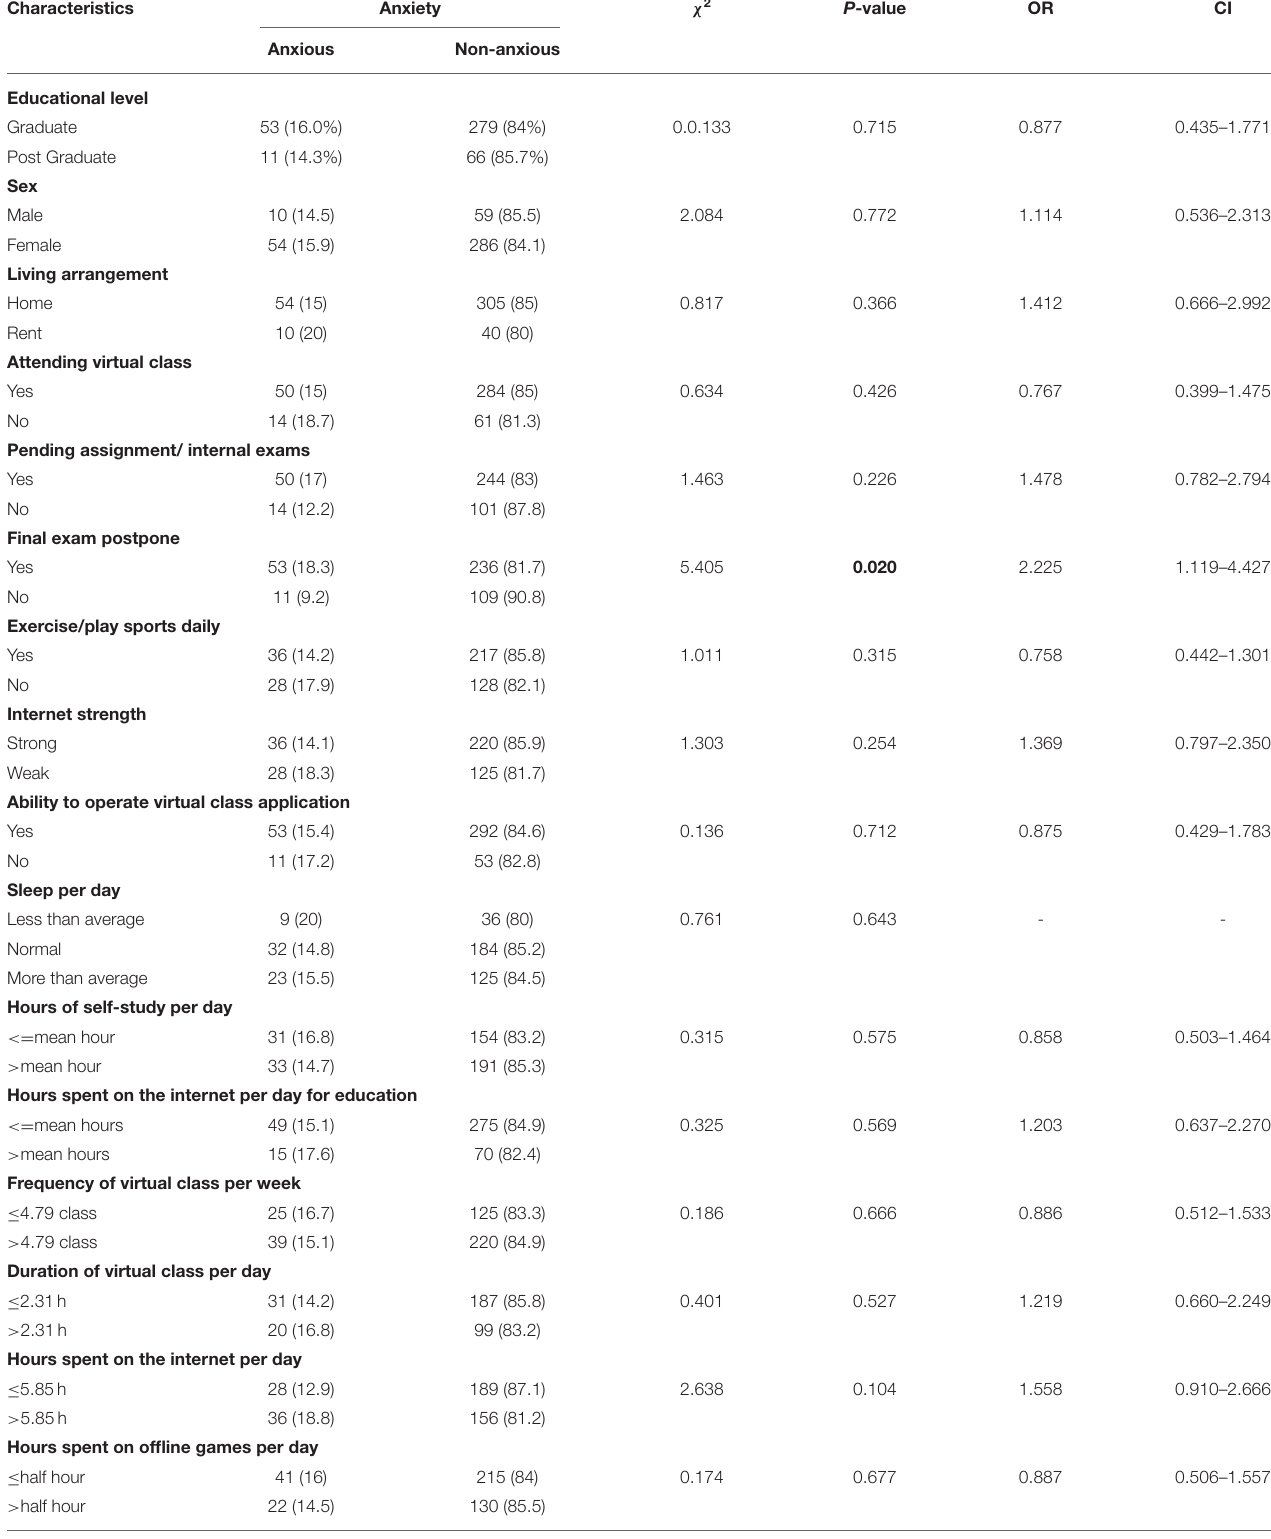
TABLE 6 | Bi-variate analysis between Anxiety and different variables ( n = 409). Characteristics Anxiety χ 2 P -value OR CI Anxious